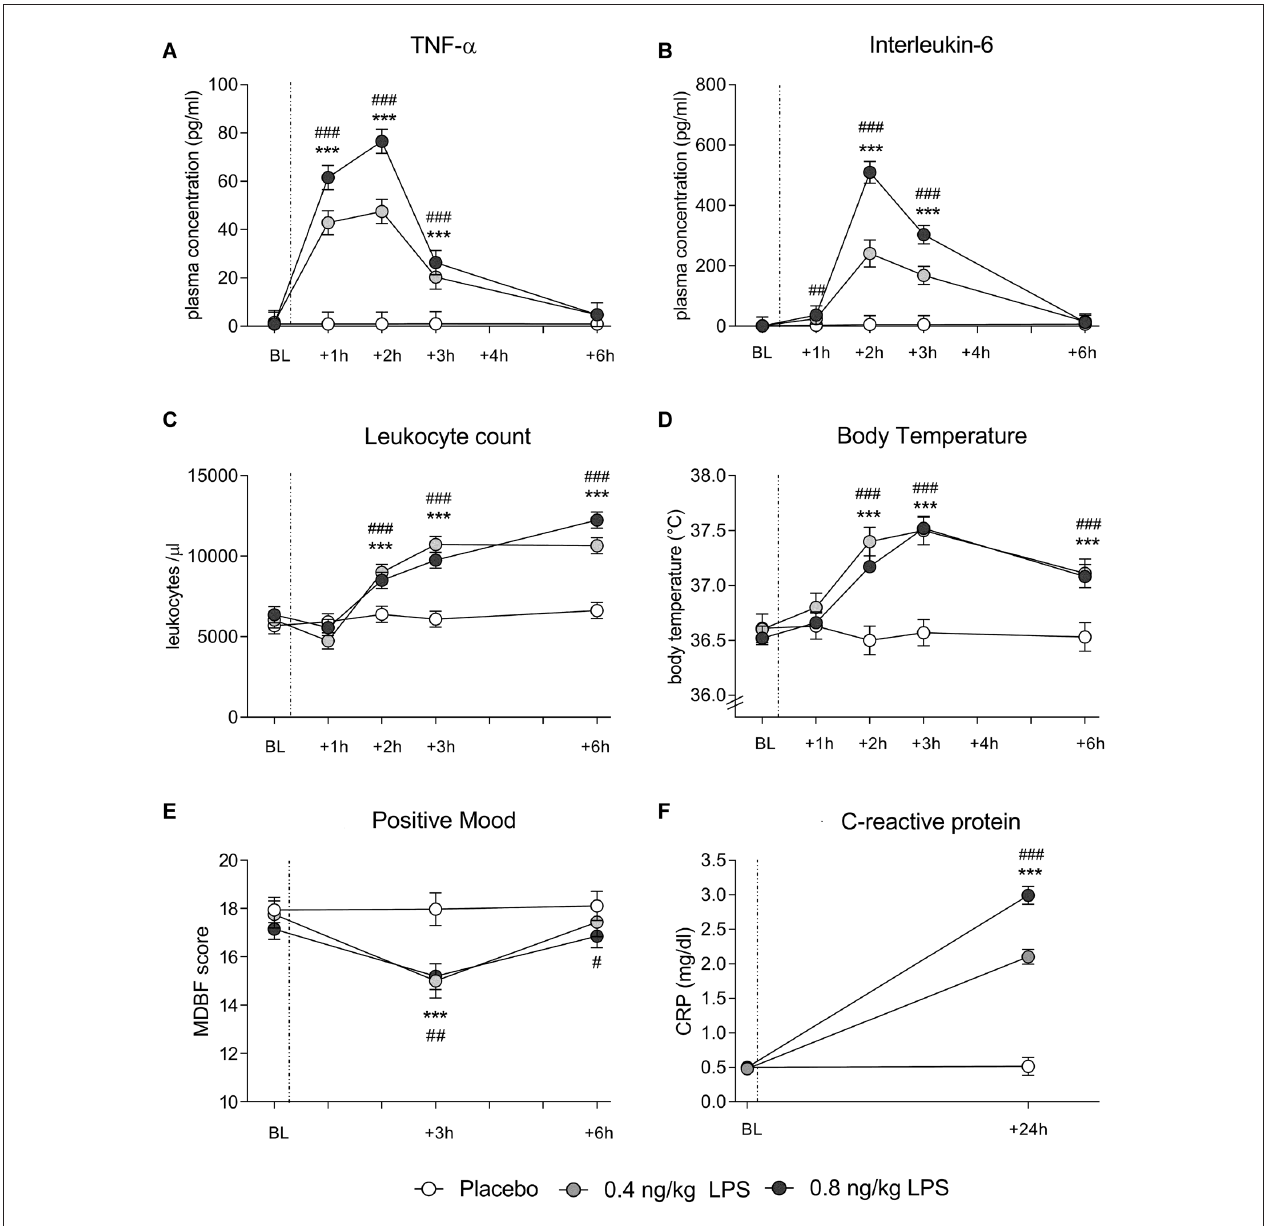
FIGURE 1 | Data set 1: plasma concentrations of tumor-necrosis-factor (TNF)- α (A) and Interleukin (IL)-6 (B) leukocyte counts (C) and body temperature (D) were measured before (baseline, BL), and 1, 2, 3 and 6 h after injection of either 0.8 ng/kg body weight lipopolysaccharide (LPS; black dots), 0.4 ng/kg body weight LPS (gray dots), or saline (placebo group; white dots). Mood (E) was assessed with the respective subscale of the German Multi-Dimensional Mood (MDBF) questionnaire at BL, as well as 3 and 6 h after injection. C-reactive protein (CRP) (F) was measured at BL and 24 h post injection. ### p < 0.001, ## p < 0.01, # p < 0.05 0.8 ng/kg LPS group vs. placebo group. ∗∗∗ p < 0.001, 0.4 ng/kg LPS group vs. placebo group. For results of repeated measures analysis of variance (ANOVA), see text.